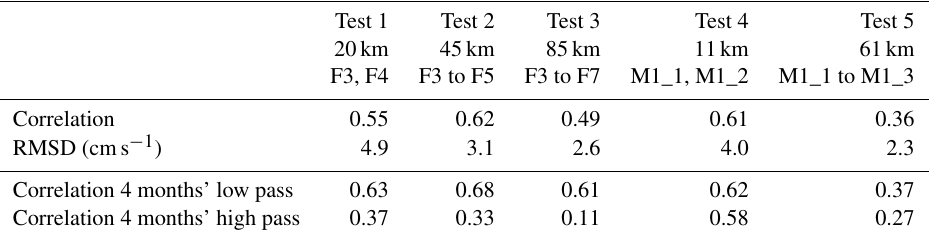
Figure 12. As in Fig. 11 but for velocities at the Laptev Sea continental slope, along longitude 126 ◦ 50 (cid:48) E (see Fig. 1). The component of the velocity normal to the transect is positive eastward. The time series in panel (a) correspond to test 4 (see text). Table 5. Comparison of spatially averaged altimetry and mooring velocity at the mooring lines. Each test (described in Sect. 5.2.2, “Spatial and temporal resolution”) corresponds to the averaging of data from two or more moorings (names of moorings used in each test and cross- flow distance covered by them are indicated in the header). The first two rows show the Pearson correlation coefficient and RMSD between horizontally averaged v n and v ni . The last two rows show correlations at frequencies lower and higher than 4 months. All correlations in this table have a p value < 0 . 01, computed using the effective number of degrees of freedom (Emery and Thomson,